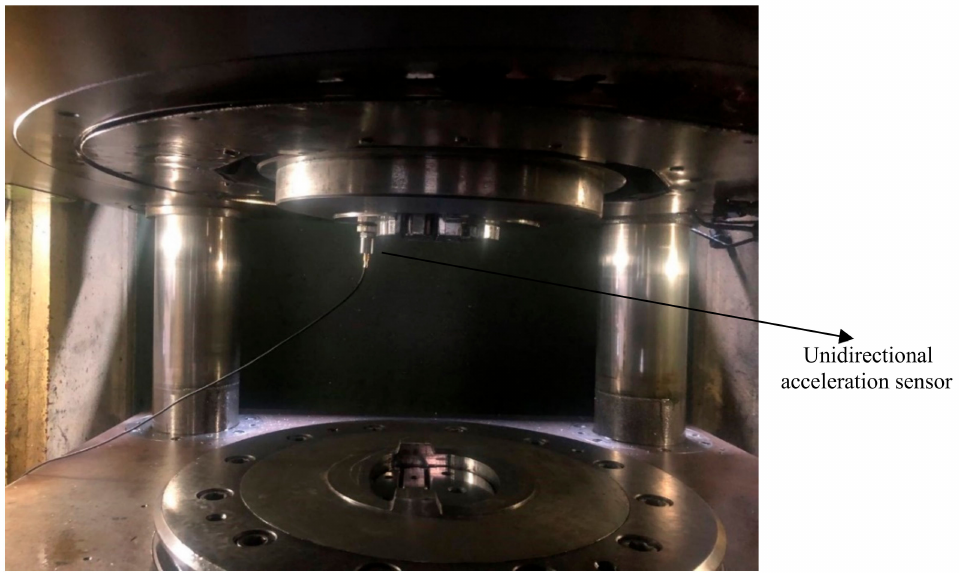
Figure 18. Installation site of the unidirectional acceleration sensor. In LMS software, the vertical acceleration signal of the swing shaft was fast Fourier transformed. The time-domain signal of the vertical acceleration of the swing shaft was transformed to a frequency-domain signal. The experimental vertical acceleration frequency-domain curve of the swing shaft is shown in Figure 19. It can be seen that the vertical vibration of the swing shaft is a low-frequency vibration and the frequencies of vertical acceleration with high amplitude are 4 Hz and 69 Hz. If we compare Figures 14 and 19, the simulation frequencies of vertical acceleration with high amplitude are very close to the experimental frequencies. The dynamic model of the COF machine is verified effectively.